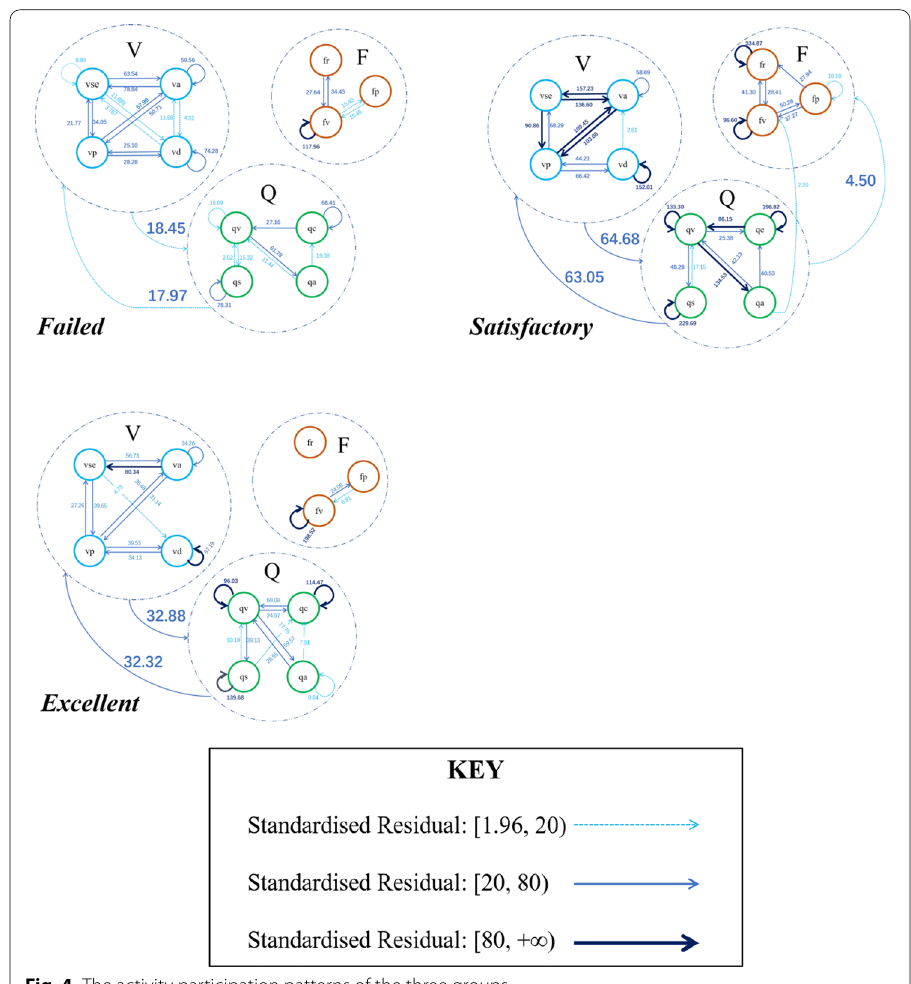
Fig. 4 The activity participation patterns of the three